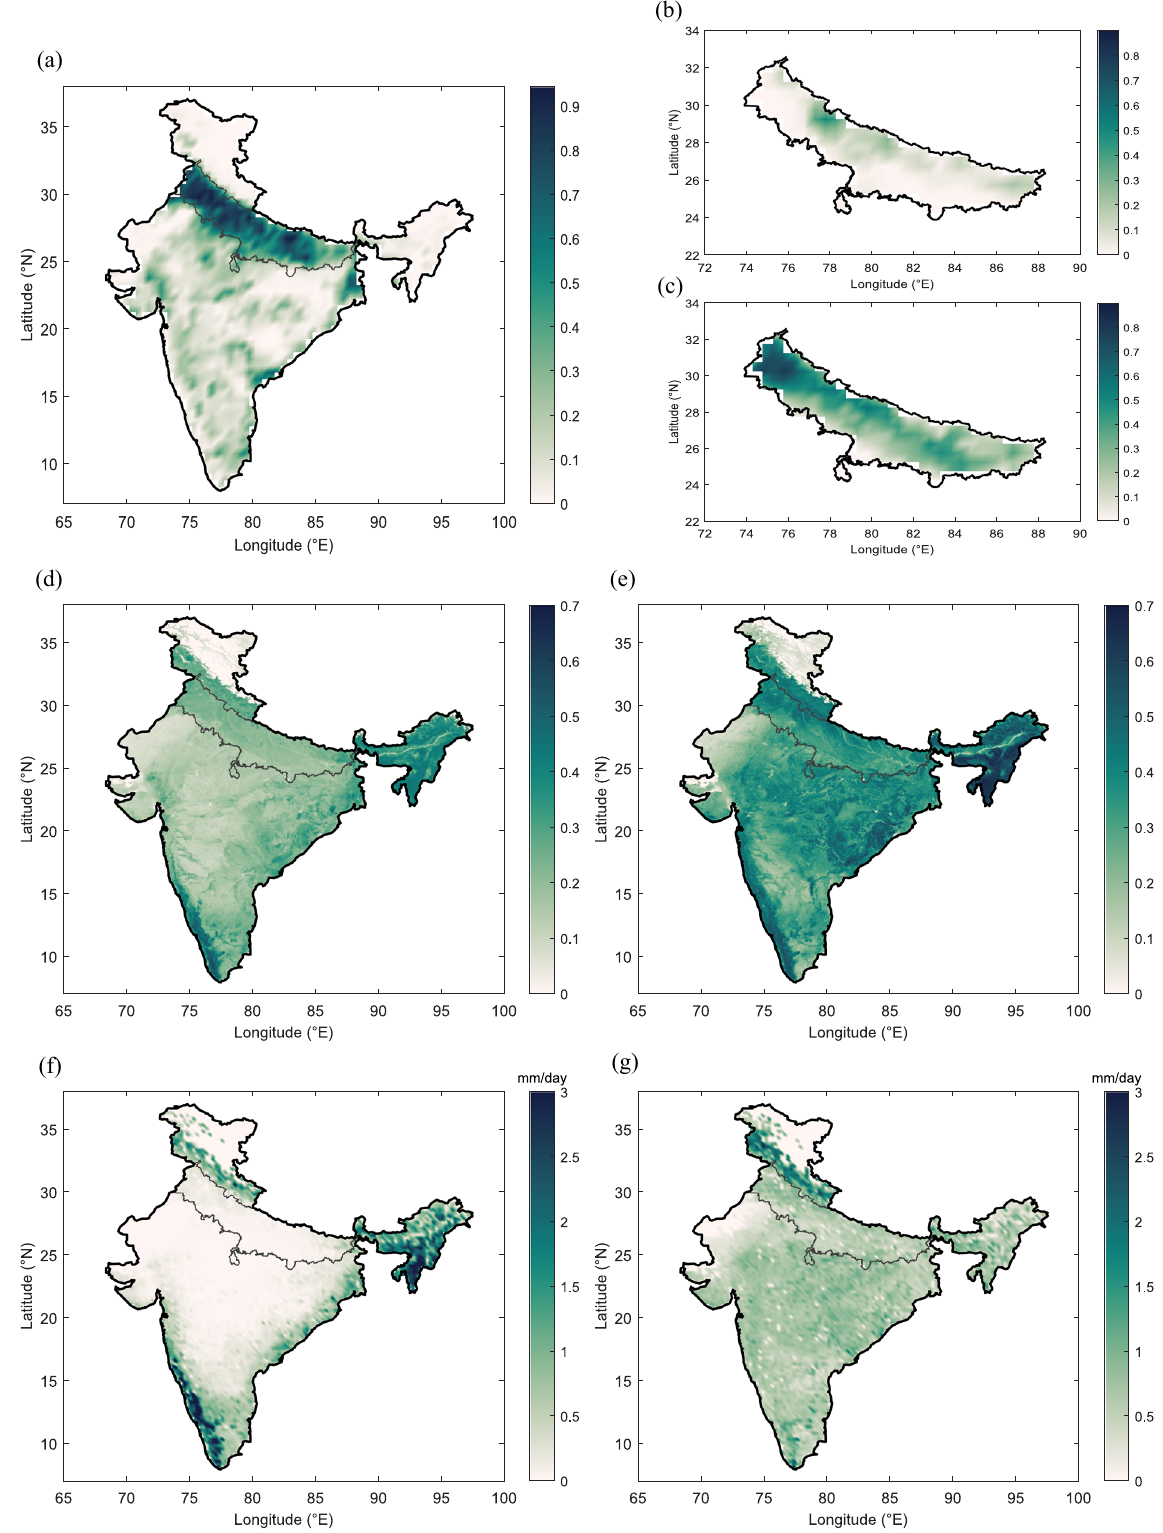
Fig. 1 Comparison of pre-monsoon (April – May) and monsoon (June – September) in India. a FAO annual irrigation fraction over India; Mean (2004 – 2016) fraction of grid cell under irrigation including paddy and non-paddy crop from agricultural census-based data during b Pre-monsoon c Monsoon; Mean EVI for the period 2001 – 2020 from moderate resolution imaging spectroradiometer (MODIS) for d pre-monsoon e monsoon; Mean ET (mm/day) for the period 2001 – 2020 from MODIS for f pre-monsoon g